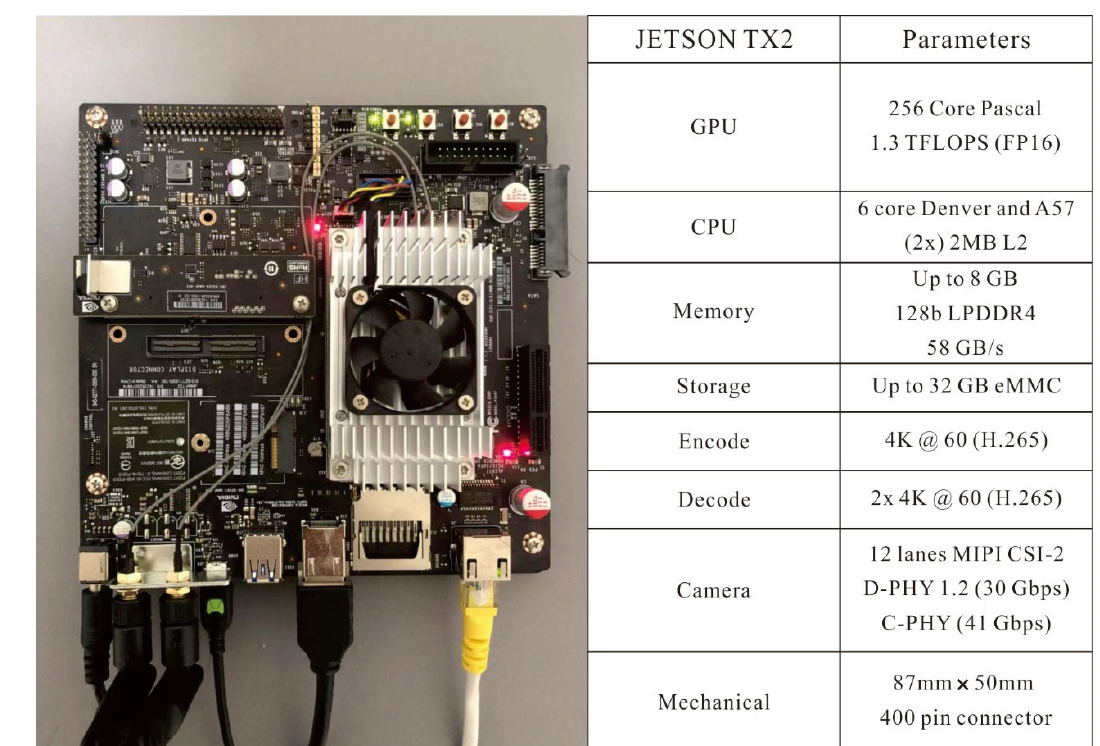
Figure 2. Some original images.